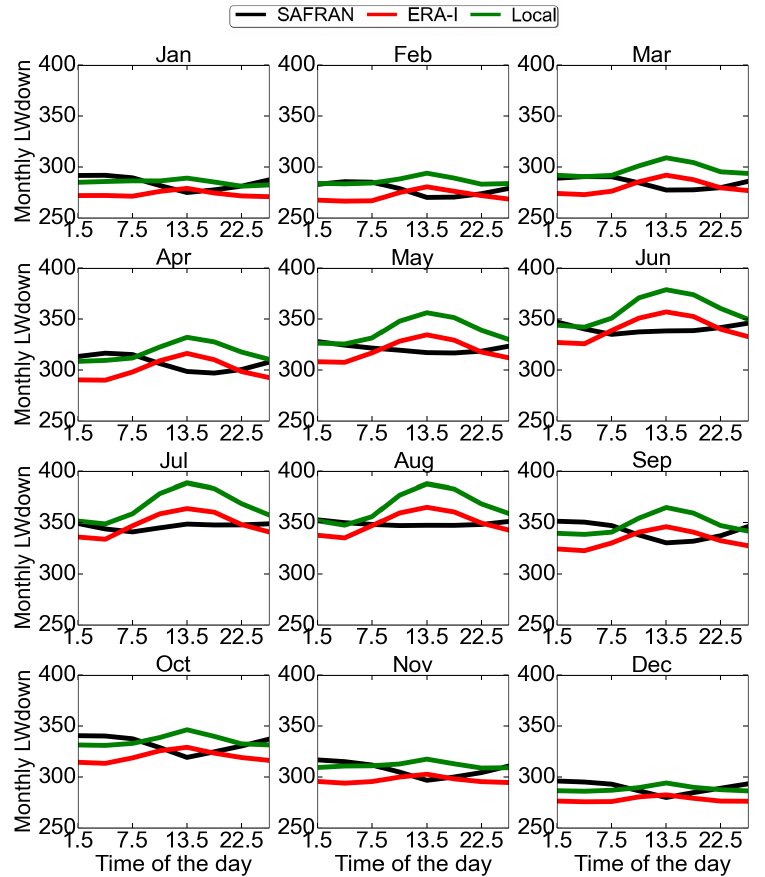
Figure 7. Comparison of SAFRAN, ERA-I and in situ mean monthly downwelling longwave radiation (LWdown inWm − 2 ) over the 25 April 2001–25 June 2012 period. The estimates correspond to 3h integrated